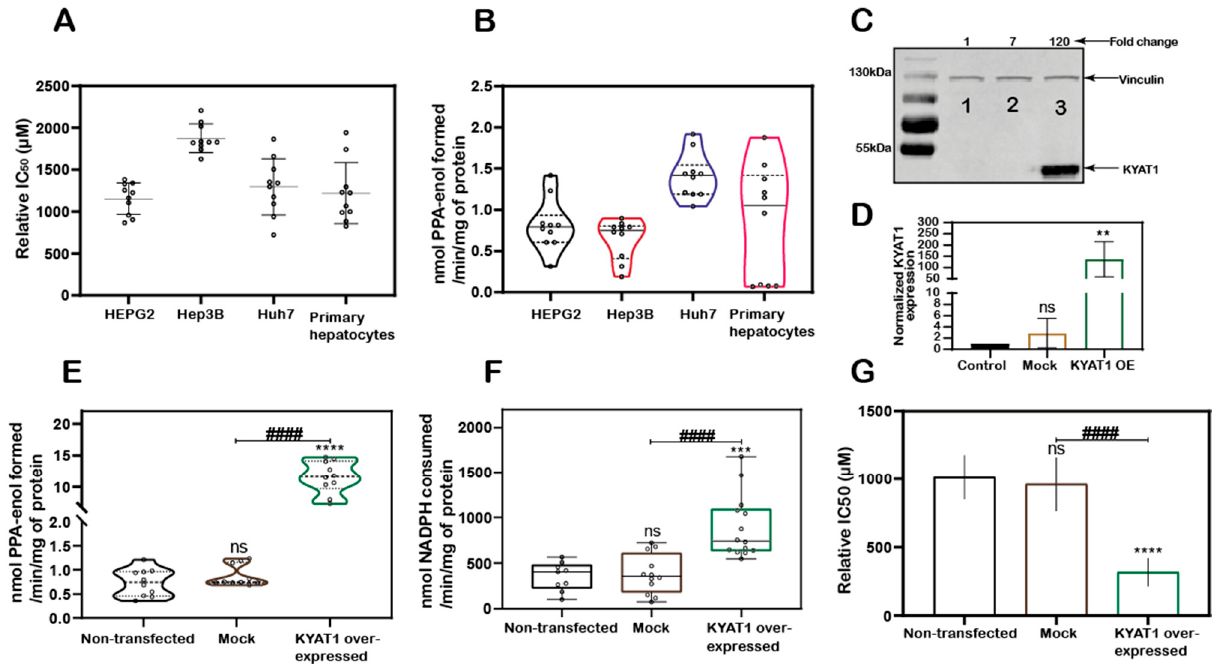
Figure 1. KYAT1 expression and MSC cytotoxicity in cancer and normal human liver hepatocytes. ( A ) MSC cytotoxicity in three different hepatocellular carcinoma cell lines (HEPG2, Hep3B, and Huh7) and freshly isolated human primary hepatocytes at 72 h ( n = 10). ( B ) Transamination activity of KYAT1 in three HCC cell lines and human primary hepatocyte ( n = 10). ( C , D ) Western blot showing the expression and quantification of over-expressed KYAT1 enzyme after 48 h of transfection in HEPG2 cells. (1) control, (2) mock-transfected, and (3) KYAT1-over-expressing plasmid-transfected cells ( n = 4). ( E ) Transamination activity ( n = 10) and ( F ) Beta-elimination ( n = 9–14) activity in control, mock, and KYAT1 over-expressed HEPG2 cell lysate. ( G ) KYAT1 over-expression increases the sensitivity of MSC-mediated cytotoxicity at 72 h in HEPG2 cells ( n = 14). ( C , D ) KYAT1 48 kDa and Vinculin 124 kDa were used as a loading control and 20 µ g of protein from cell lysate was used. ( E – G ) Graph represents mean ± SD, statistical analysis performed with one-way ANOVA with 95% confidential interval followed by Tukey’s multiple comparison test (ns = not significant, * p < 0.05, ** p < 0.01, *** p < 0.001, and **** p < 0.0001 compared with untransfected control and # p < 0.05, ## p < 0.01, ### p < 0.001, and #### p < 0.0001 compared with mock).